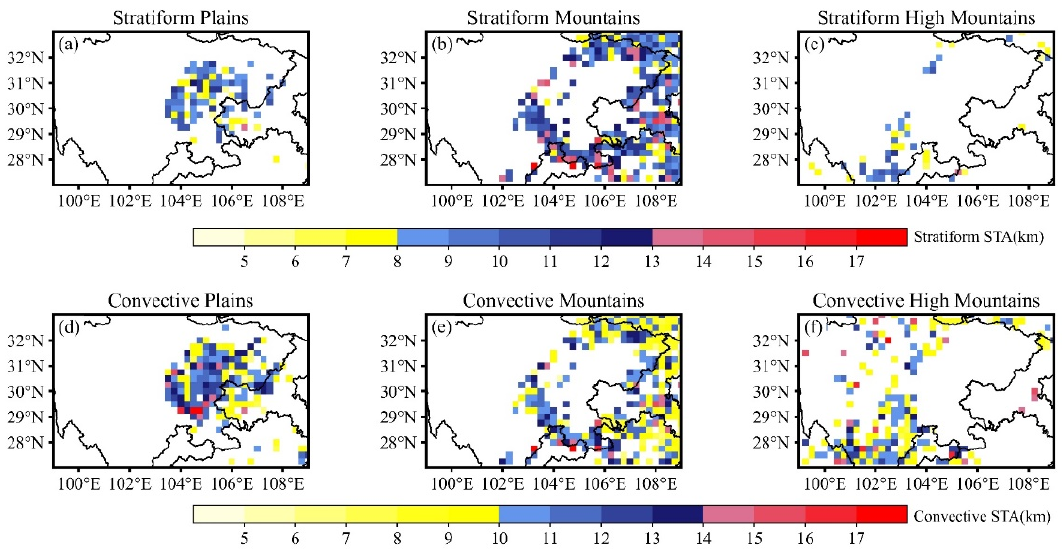
Figure 10. The horizontal Distribution of storm top altitude of two types of heavy precipitation over plains ( a , d ), mountains ( b , e ), and high mountains ( c , f ).